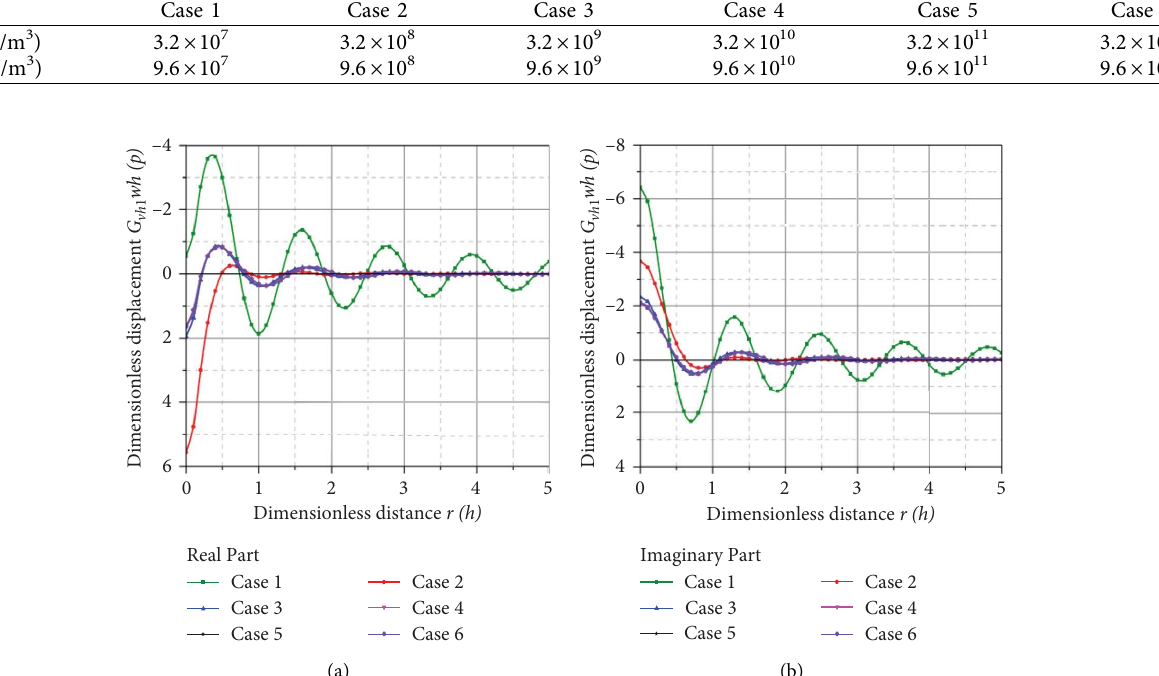
Table 3: Te interface contact parameters ( t